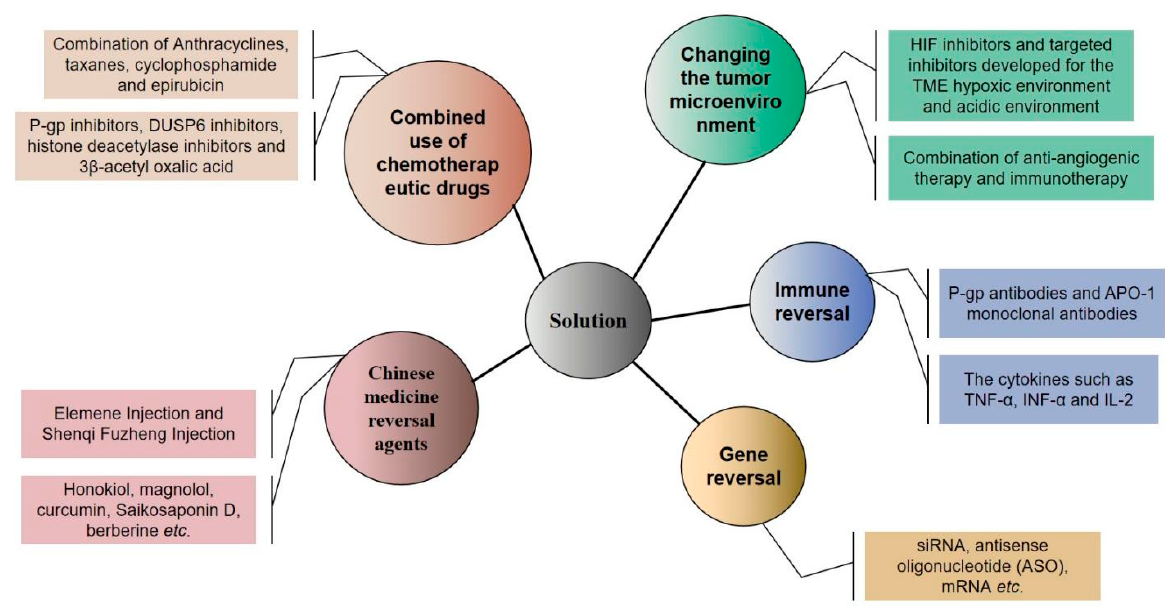
Figure 3. Strategies to combat resistance to neoadjuvant chemotherapy drugs in breast cancer.